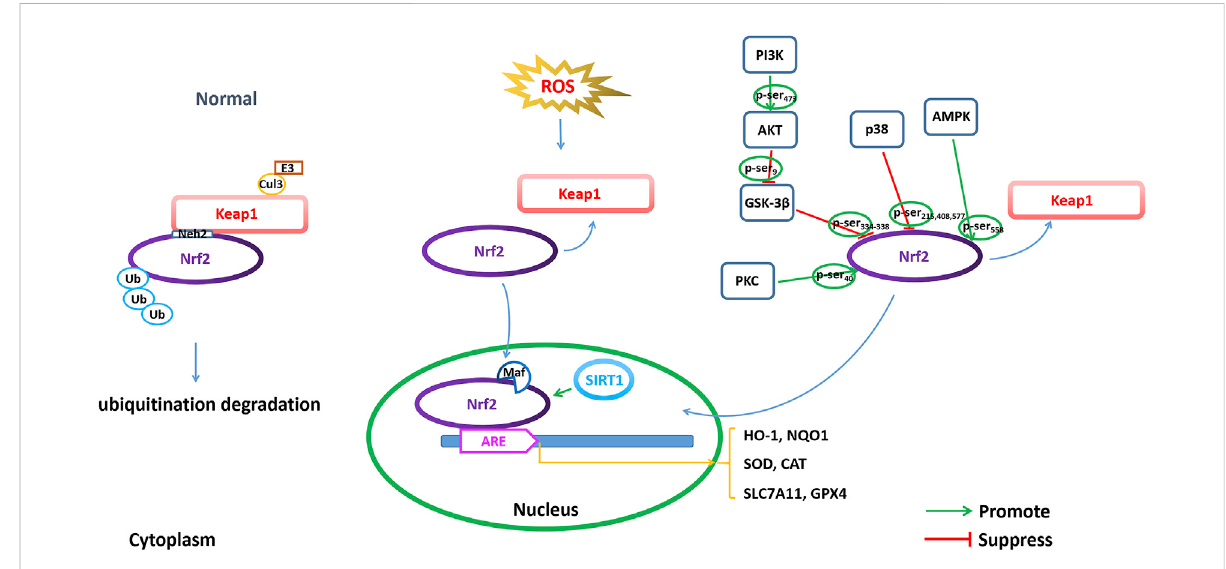
FIGURE 4 Modulating NRF2 to regulate ferroptosis. Regulation of ferroptosis through transcriptional and posttranscriptional regulation of Nrf2 is important for AD pathophysiology, including Nrf2 expression, Nrf2 phosphorylation and